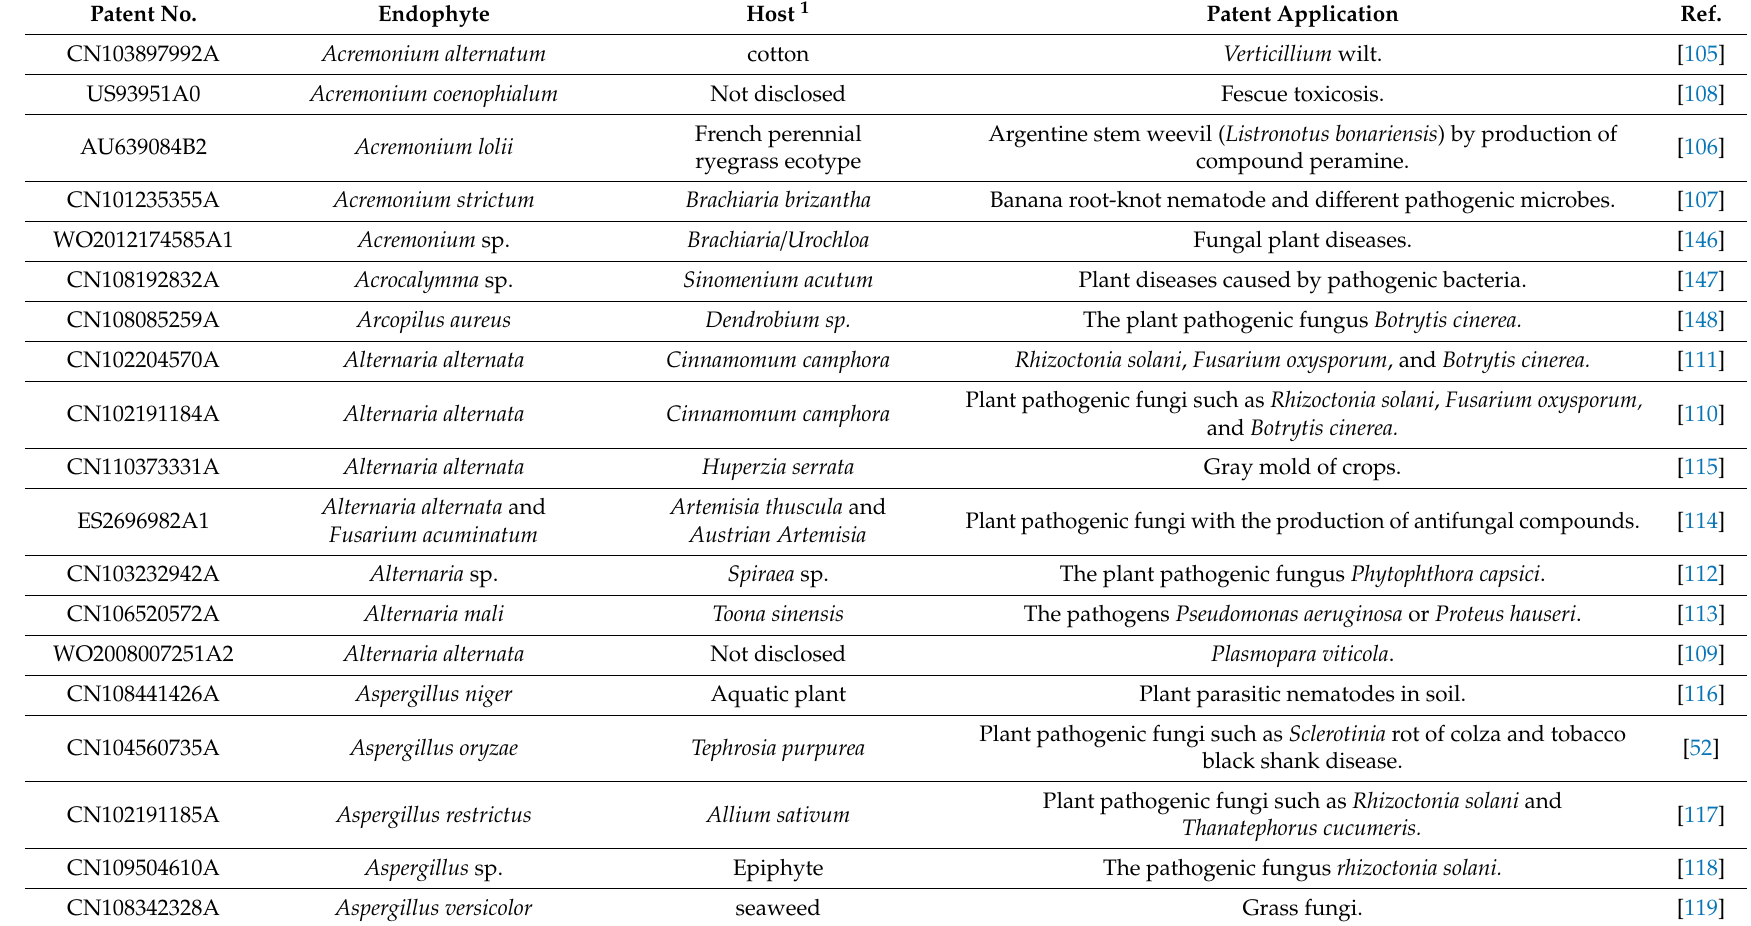
Table 3. Endophytic fungi applied as biocontrol agents of herbivores and plant